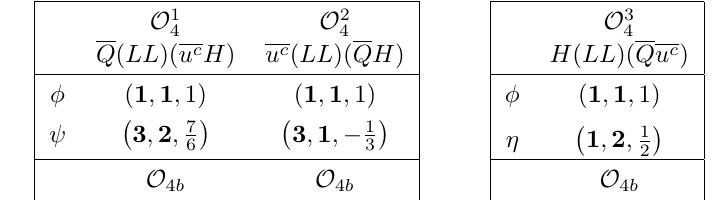
Table 4 . Minimal UV completions of the operators is generated. Fields (cid:30) and (cid:17) are scalars, while the (cid:12)elds are vectorlike fermions.